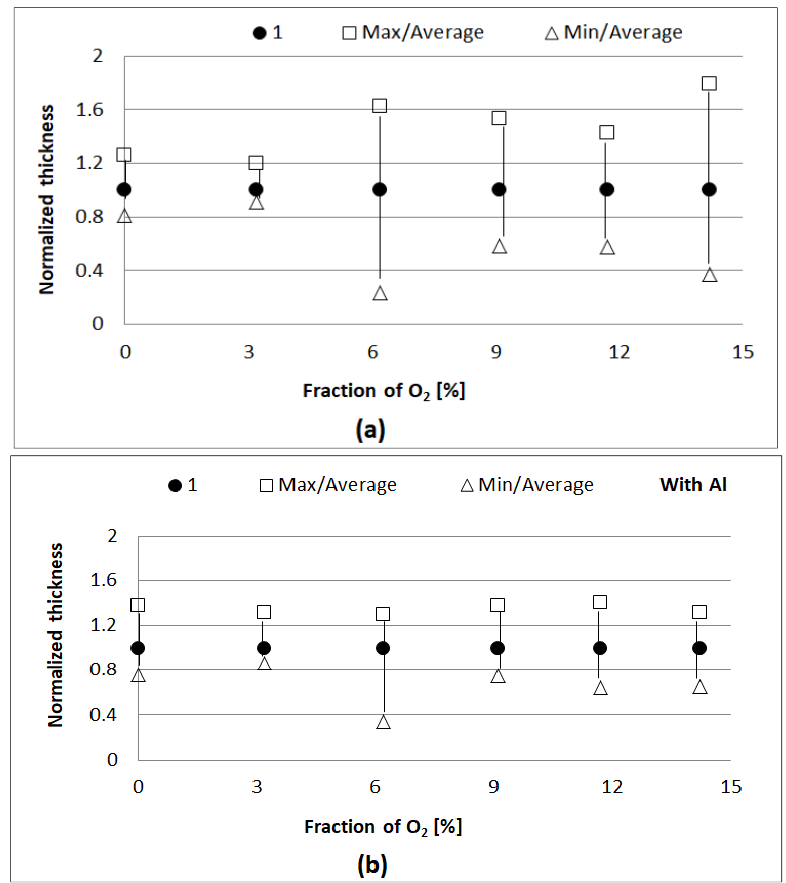
Figure 9. Normalized thickness as a function of fraction of O 2 in the case ( a ) without the Al outer anode; and ( b ) with the Al outer anode.